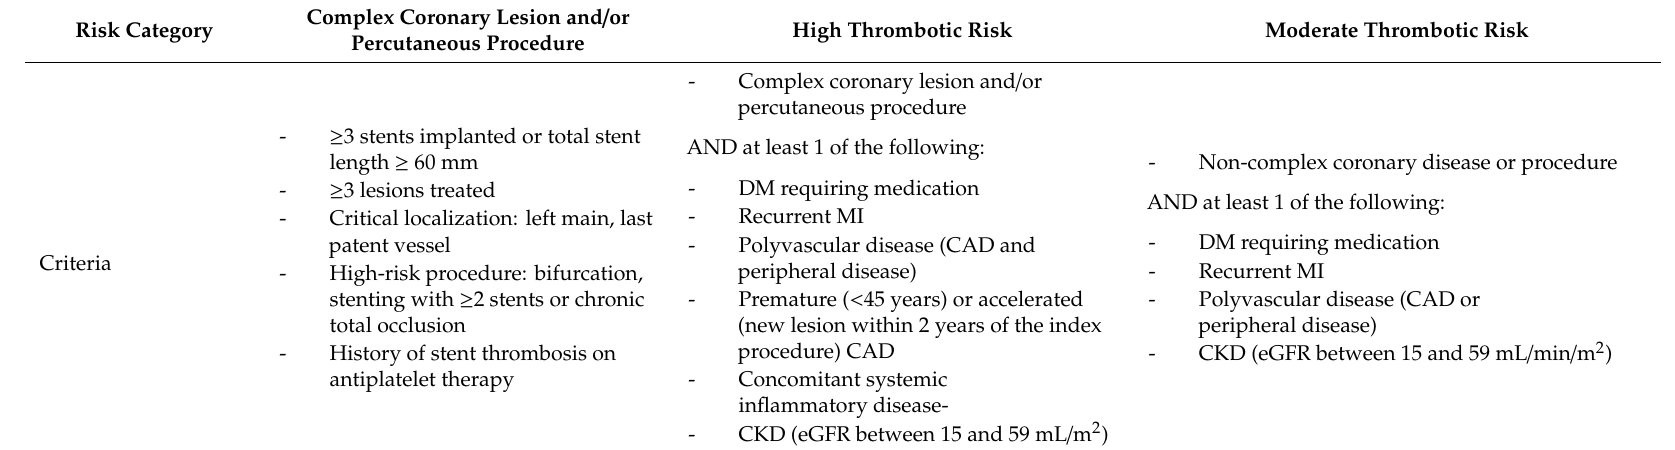
Table 2. Thrombotic risk factors according to the 2020 ESC NSTEMI